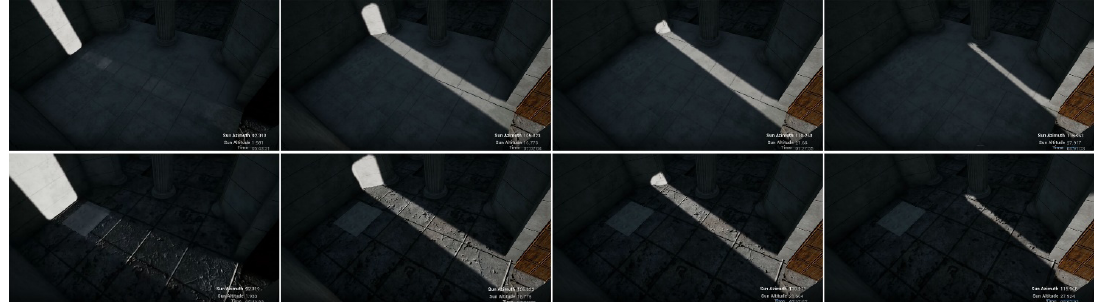
Figure 4. Virtual reality simulation model of the temple’s interior showing the visual effect of sunrise during the equinoxes between 500–100 BCE. Top row: progression of sunbeam at equinoxes with one door leaf open. Bottom row: progression of sunbeam at equinoxes with both door leafs open.